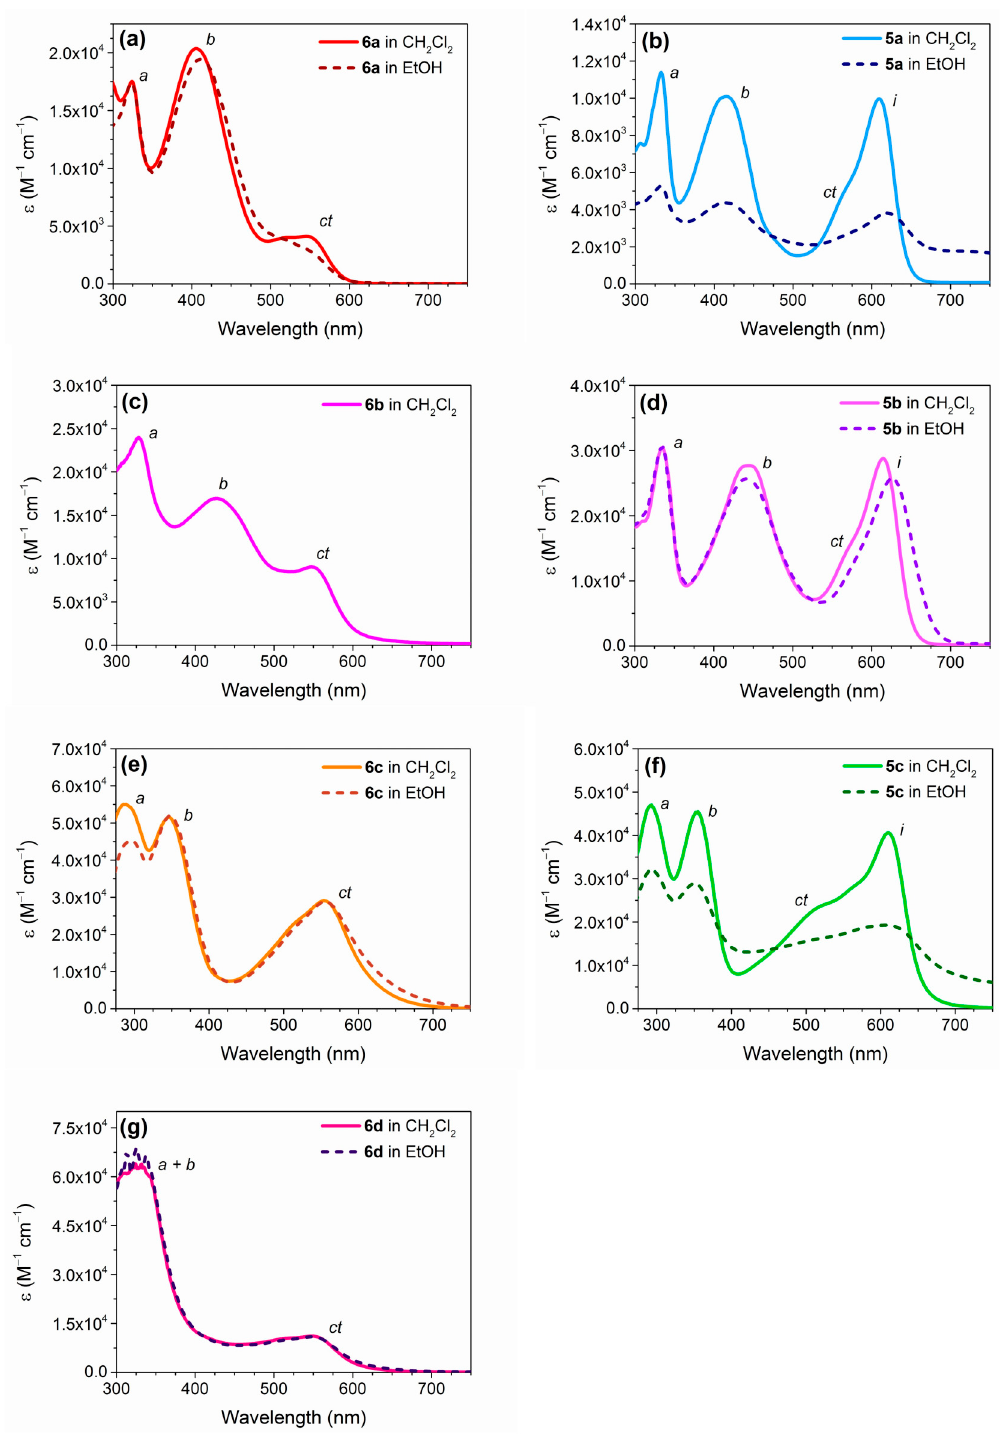
Figure 5. UV-Vis absorption spectra of dyes 6a–d (panels ( a ), ( c ), ( e ), ( g ), respectively) and 5a–c (panels ( b ), ( d ), ( f ), respectively).